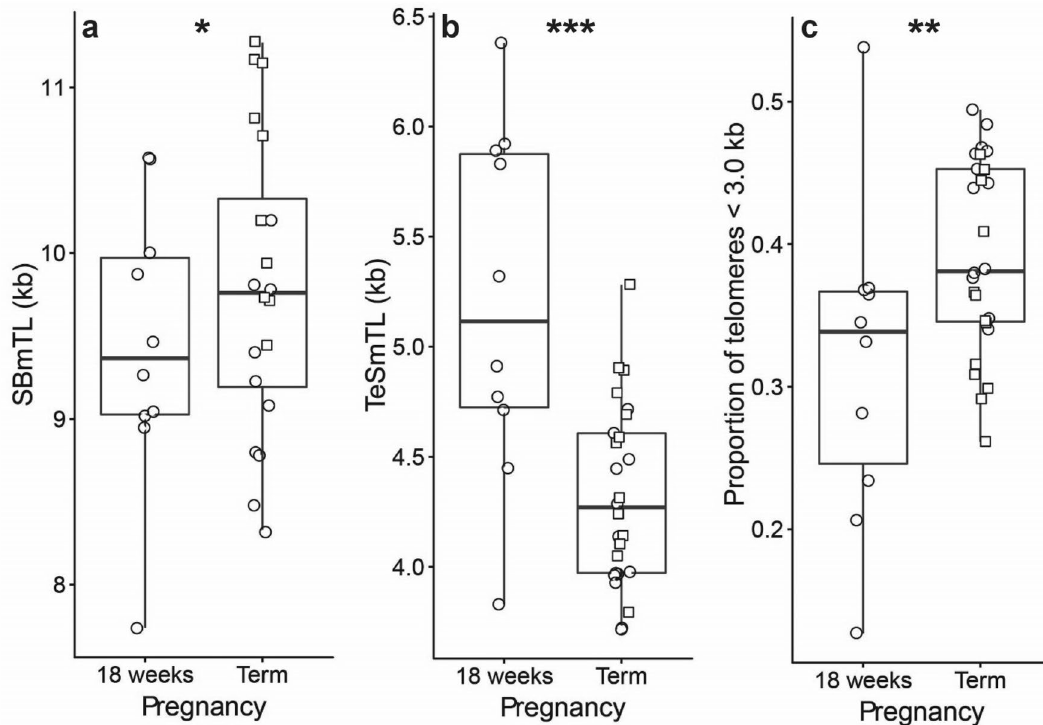
Figure 4. Telomere length in the chorioamniotic membranes (CAMs) at 18-weeks of gestation (n = 10) and at full term (n = 13). Southern blot mean telomere length (SBmTL) ( a ); TeSLA mean telomere length (TeSmTL) ( b ); proportion of telomeres shorter than 3.0 kb (TeSLA measurements) ( c ). Note that at 18 weeks the measurements are for the chorionic membrane (CM) and amniotic membrane (AM) combined, i.e., CAMs, since the two could not be separated. At term the two membranes could be separated (AM, squares; CM, circles), but boxplot is for the membranes pooled. * P < 0.05; ** P < 0.01; *** P < 0.001.